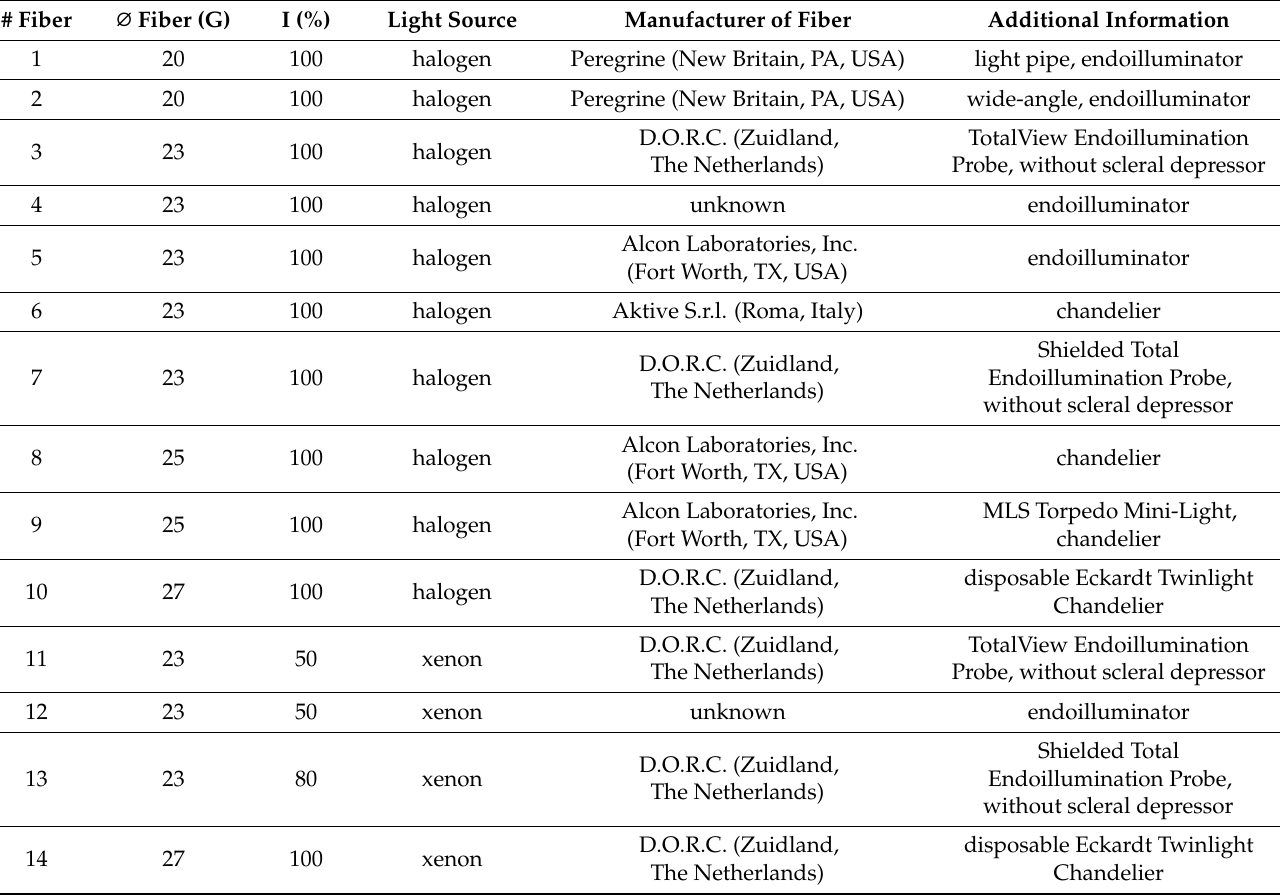
Table 1. Overview of the applied ophthalmic illumination fibers. Each fiber is assigned a number (# fiber). In addition, the fiber diameter in gauge ( ⌀ fiber (G)), the intensity of the light source (I (%)), the type of the light source, the manufacturer and, if available, additional information about the fiber is